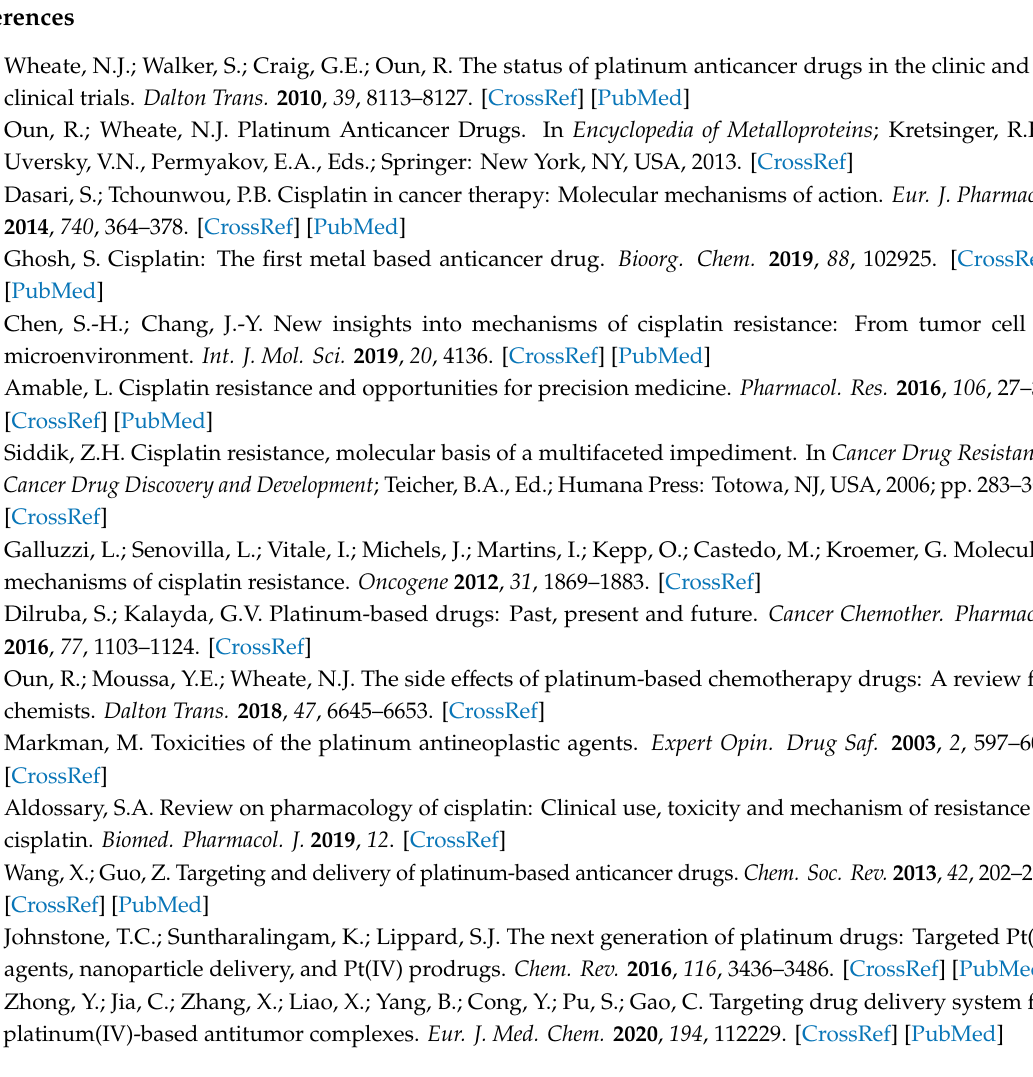
Figure S1: General structure of the dicationic and tricationic conjugates., Figure S2: Structure of acetyl ester 25 and amide 26 derivatives, Figure S3: Dose response curves for compounds 6 , 9 , 10 , 12 , 13 , 15 , 16 , 24 and 25 as inhibitors of T. gondii tachyzoites proliferation, Figure S4: 1H-NMR Spectra of 3 – 5 , 25 and 26 recorded in DMSO-d6 at 25 ◦ C, Figure S5: 1H-NMR spectra of 6 – 10 recorded in DMSO-d6 at 25 ◦ C, Figure S6: 1H-NMR spectra of 11 – 14 recorded in DMSO-d6 at 25 ◦ C, Figure S7: 1H-NMR spectra of 15 – 18 recorded in DMSO-d6 at 25 ◦ C, Figure S8: 1H-NMR spectra of 23 and 24 recorded in DMSO-d6 at 25 ◦ C, Table S1: Primary e ffi cacy / cytotoxicity screening of compounds in non-infected HFF cultures and T. gondii β -gal tachyzoites cultured in HFF, Table S2: IC50 values ( µ M) determined after 72 h exposure of HEK293, A2780, A2780cisR, A24 and (D-)A24cisPt8.0 cells to cisplatin (cisPt) and selected trithiolato-bridged dinuclear ruthenium(II)-p-cymene compounds. Reference [112] are cited in the supplementary